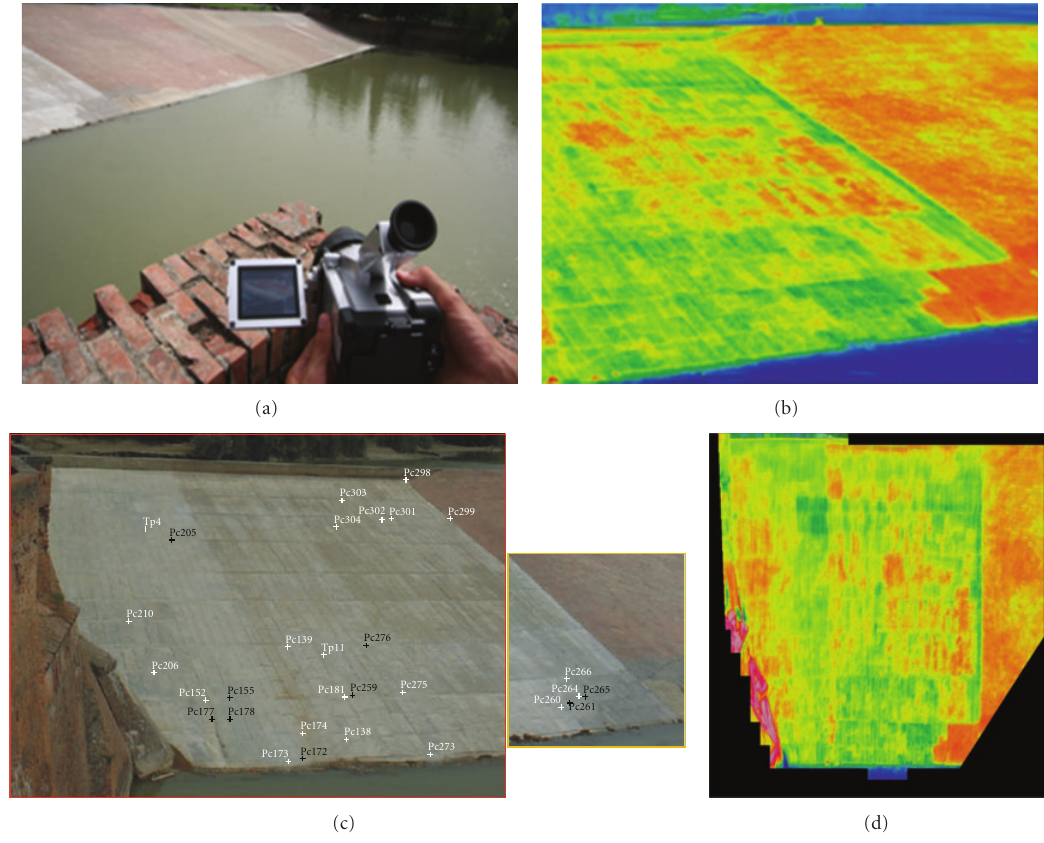
Figure 8: Thermal imagery: (a) NEC TH9100 PRO 320 × 240 thermal camera; (b) an example of thermal image characterised by 5cm pixel on the object; (c) each thermal image has been calibrated by photogrammetric procedures and oriented in the space by means of the dense clouds of laser points; (d) the thermal orthophoto of a portion of the slide showing the blocks of di ff erent material related to di ff erent restoration activities carried out in the